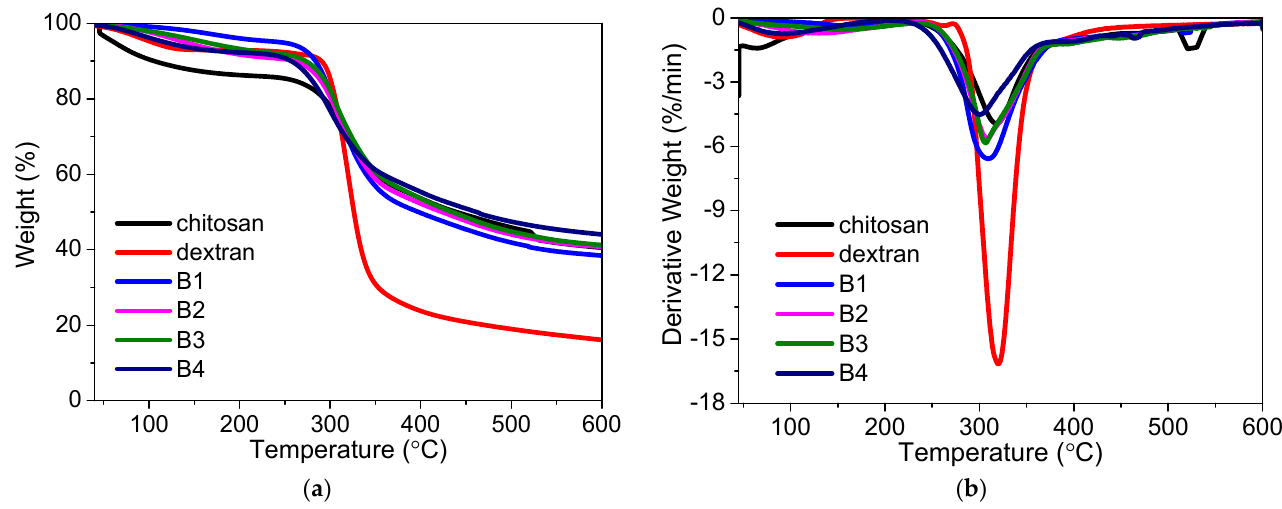
Figure 3. TGA–DTG of thermograms of chitosan, dextran, and their nanocomposites: ( a ) TGA and